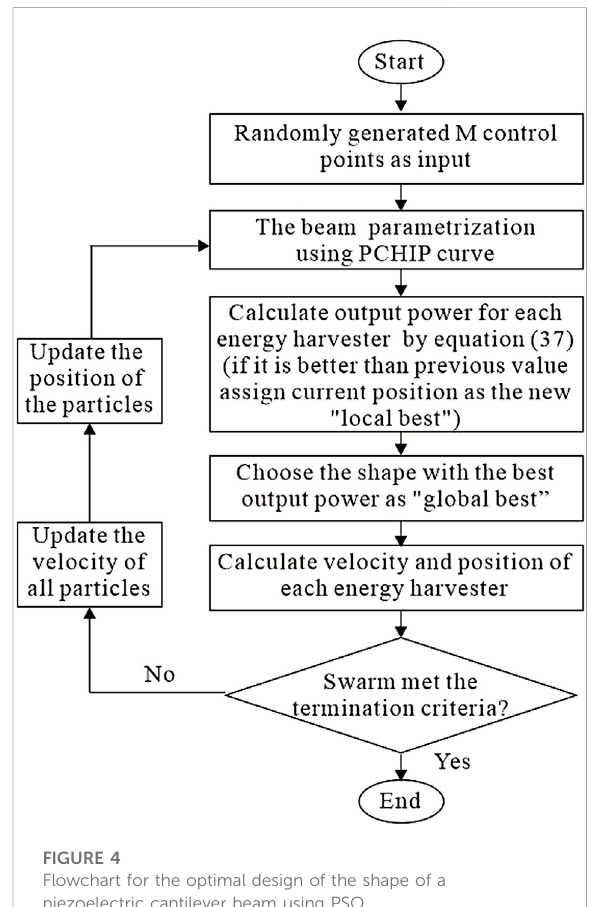
FIGURE 4 Flowchart for the optimal design of the shape of a piezoelectric cantilever beam using PSO.